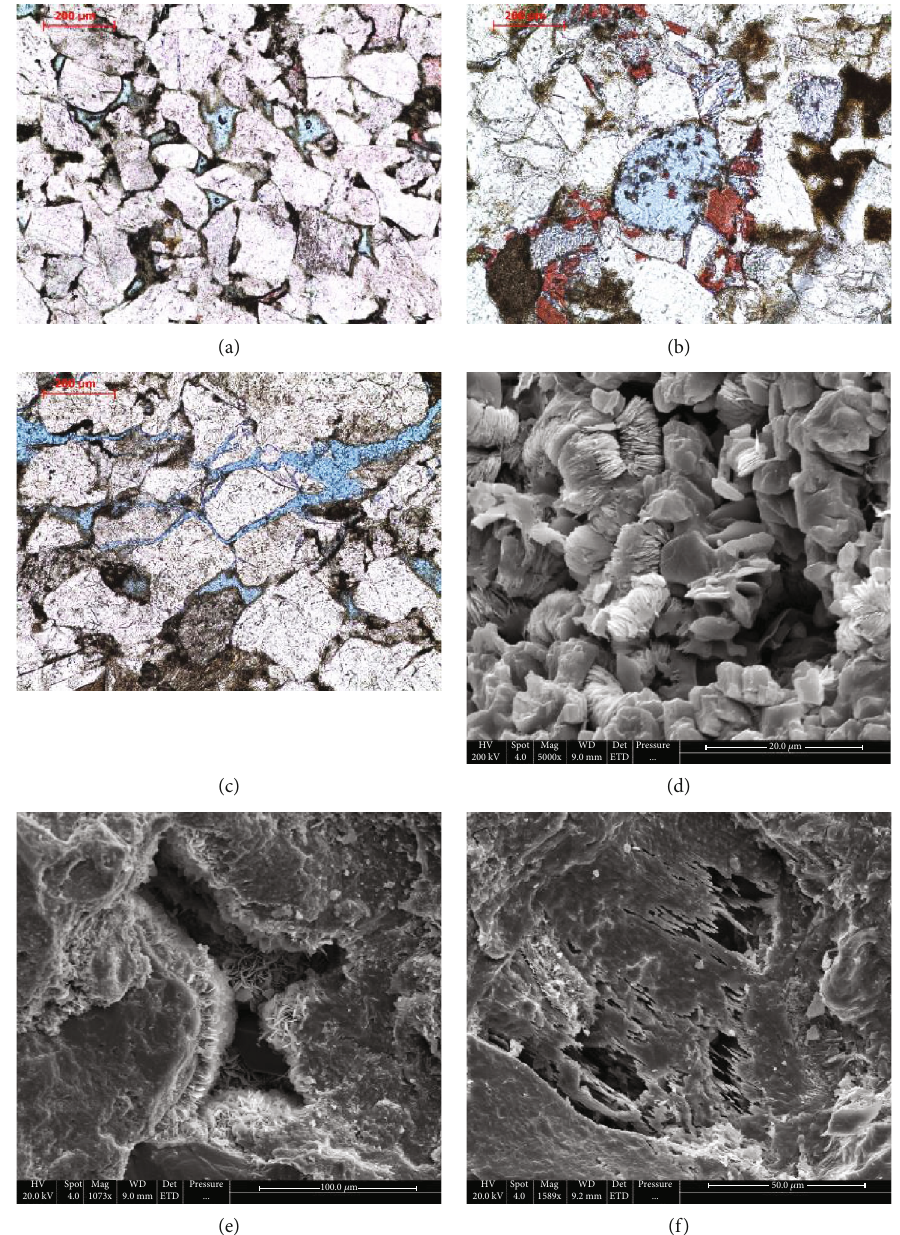
Figure 14: Pore types in the study area: (a) primary intergranular pores and dissolved intergranular pores, well X66, (-); (b) lithic dissolved pores, Shiwang river pro fi le, (-); (c) microfracture pores, well X66; (d) intercrystalline pores, well X54, (-); (e) dissolved intergranular pores and grain-coating chlorite, Shiwang river pro fi le; (f) feldspar dissolution pores, Shiwang river pro fi